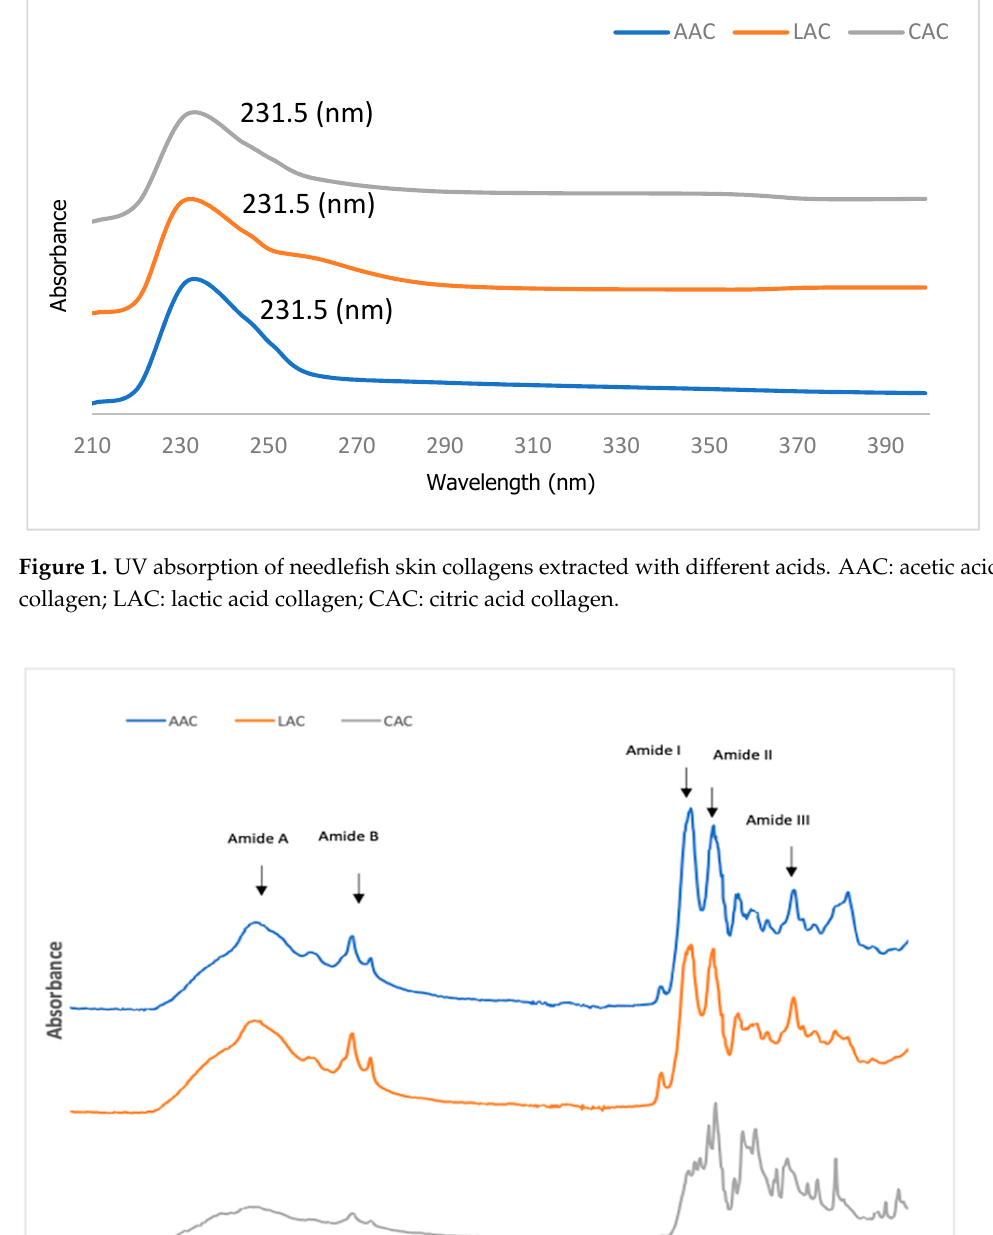
Figure 2. ATR-FTIR patterns of needlefish skin collagen extracted with different acids. AAC: acetic acid collagen; LAC: lactic acid collagen; CAC: citric acid collagen.